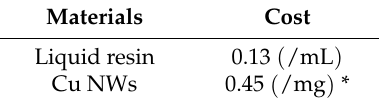
Table 3. Cost of materials. * Considering just the chemicals used for synthesis and washing of NWs.